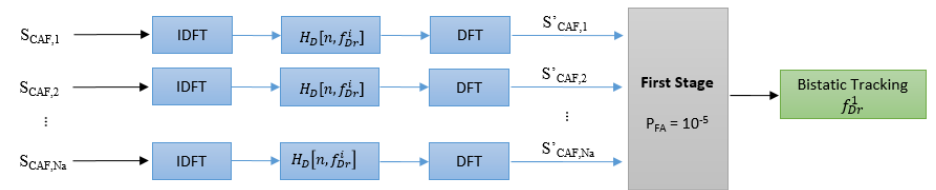
Figure 7. Doppler migration compensation scheme for f i